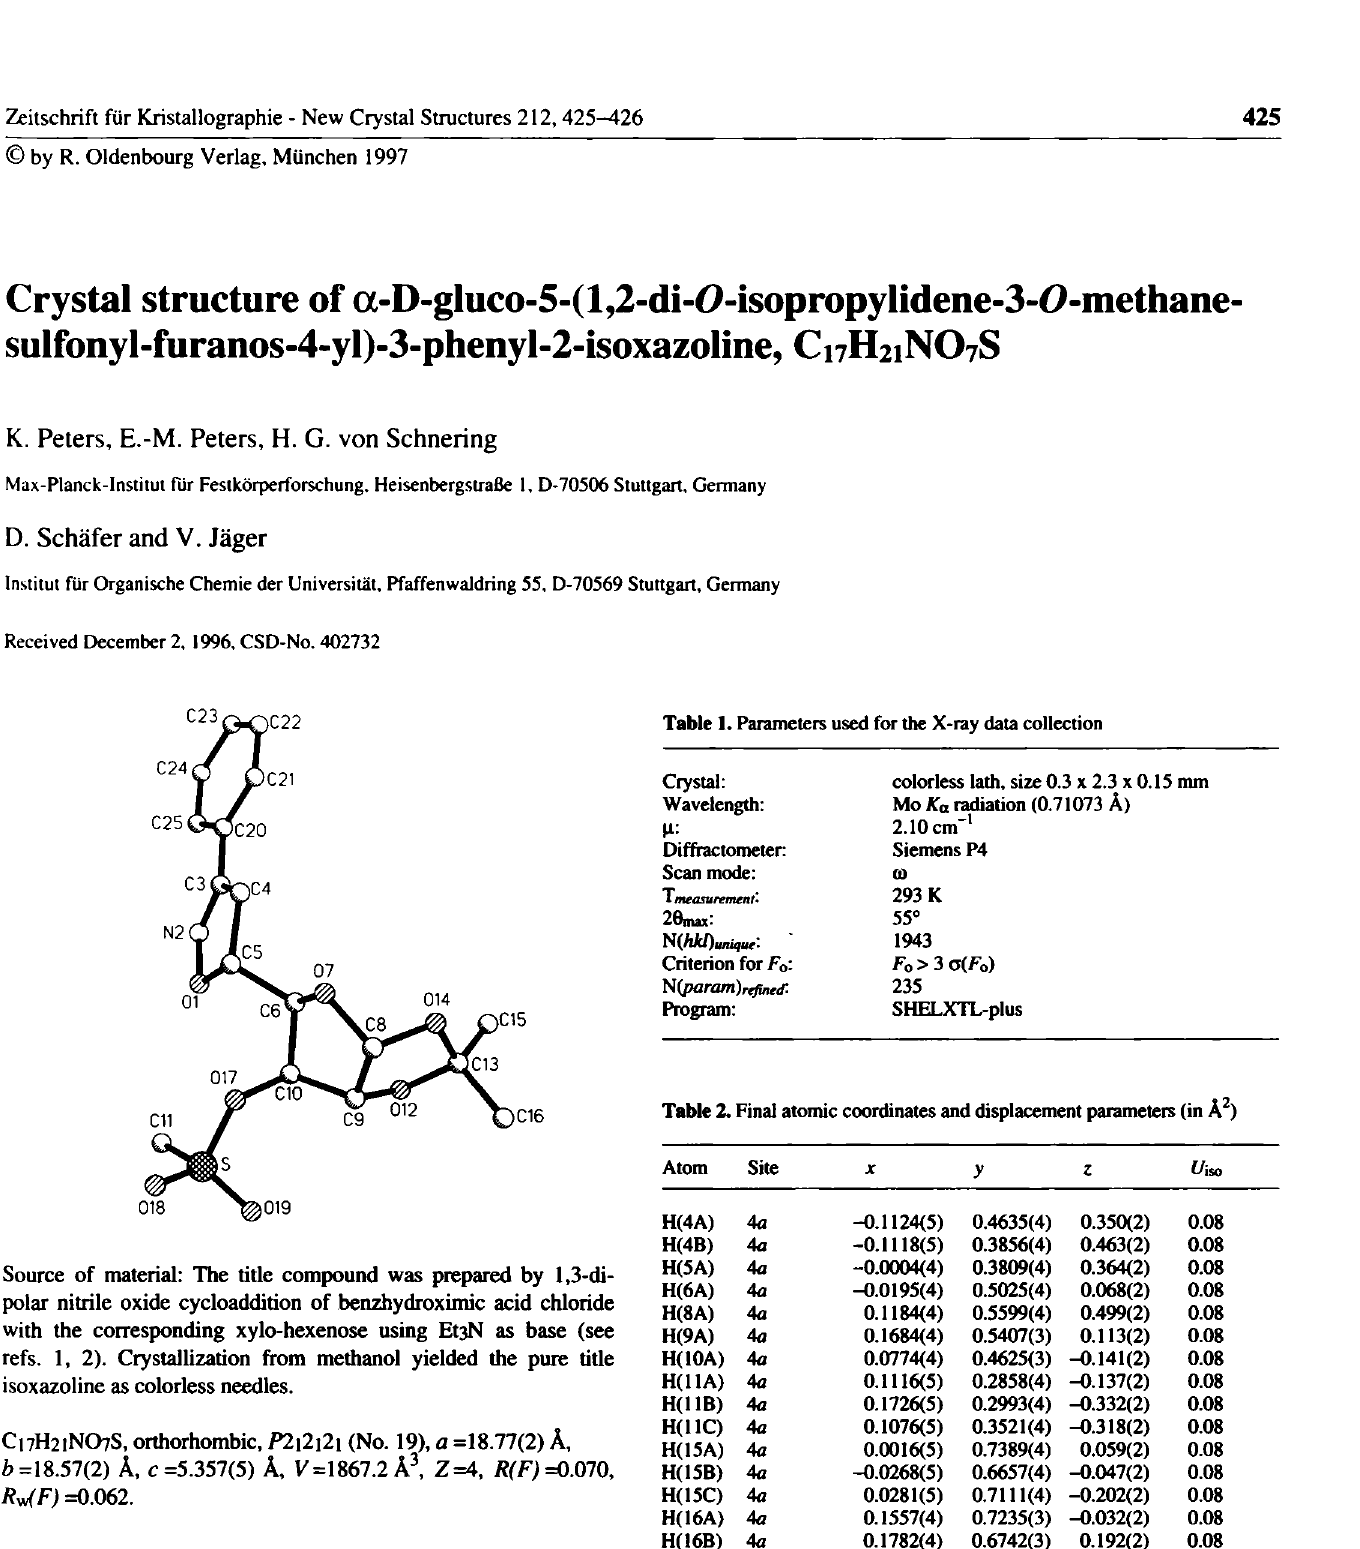
Table 2. Final atomic coordinates and displacement parameters (in Â 2 )